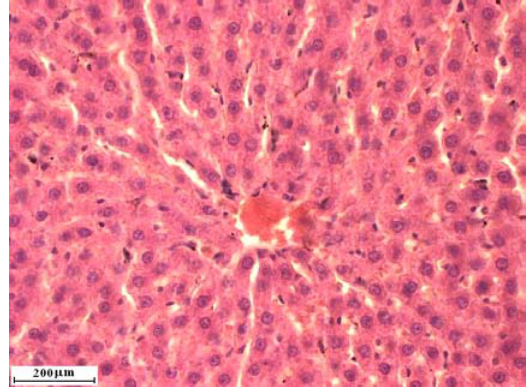
Figure 2. Liver cross section of rats treated with Coprinus comatus aqueous